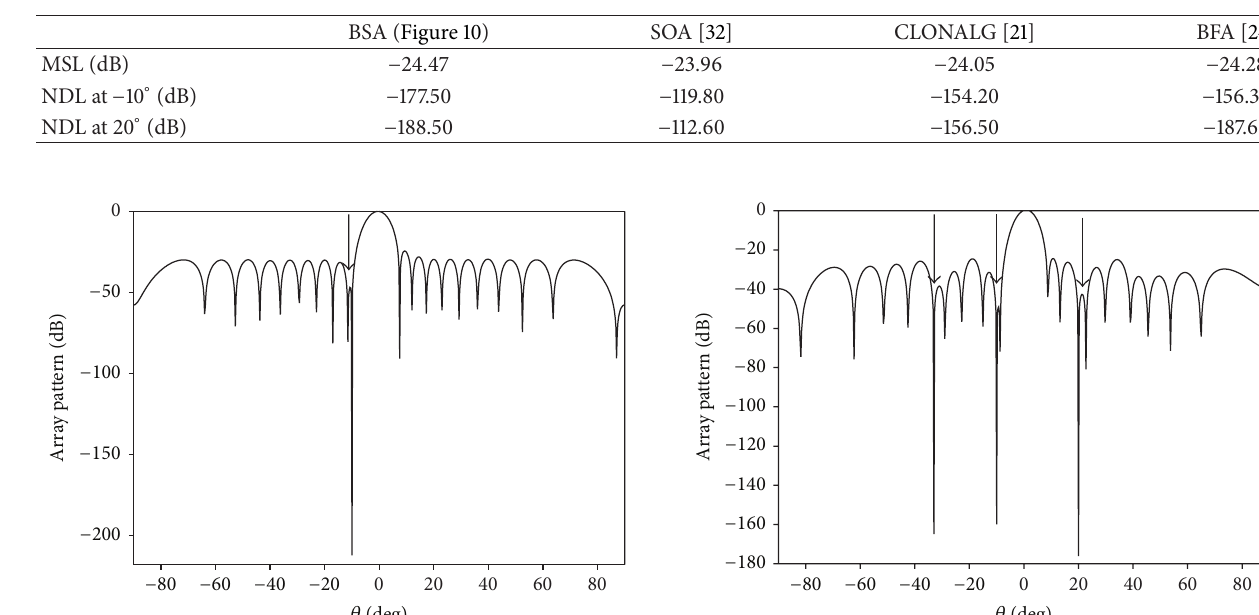
Table 4: MSL and NDL values obtained by BSA and other optimization techniques SOA [32], CLONALG [21], and BFA [24] for double null imposed at − 10 ∘ and 20 ∘ .